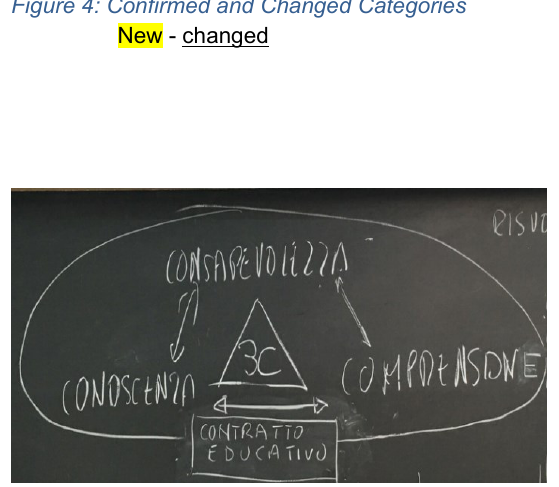
Figure 5: Model for the Educational Contract within the complexity of the Knowledge Society